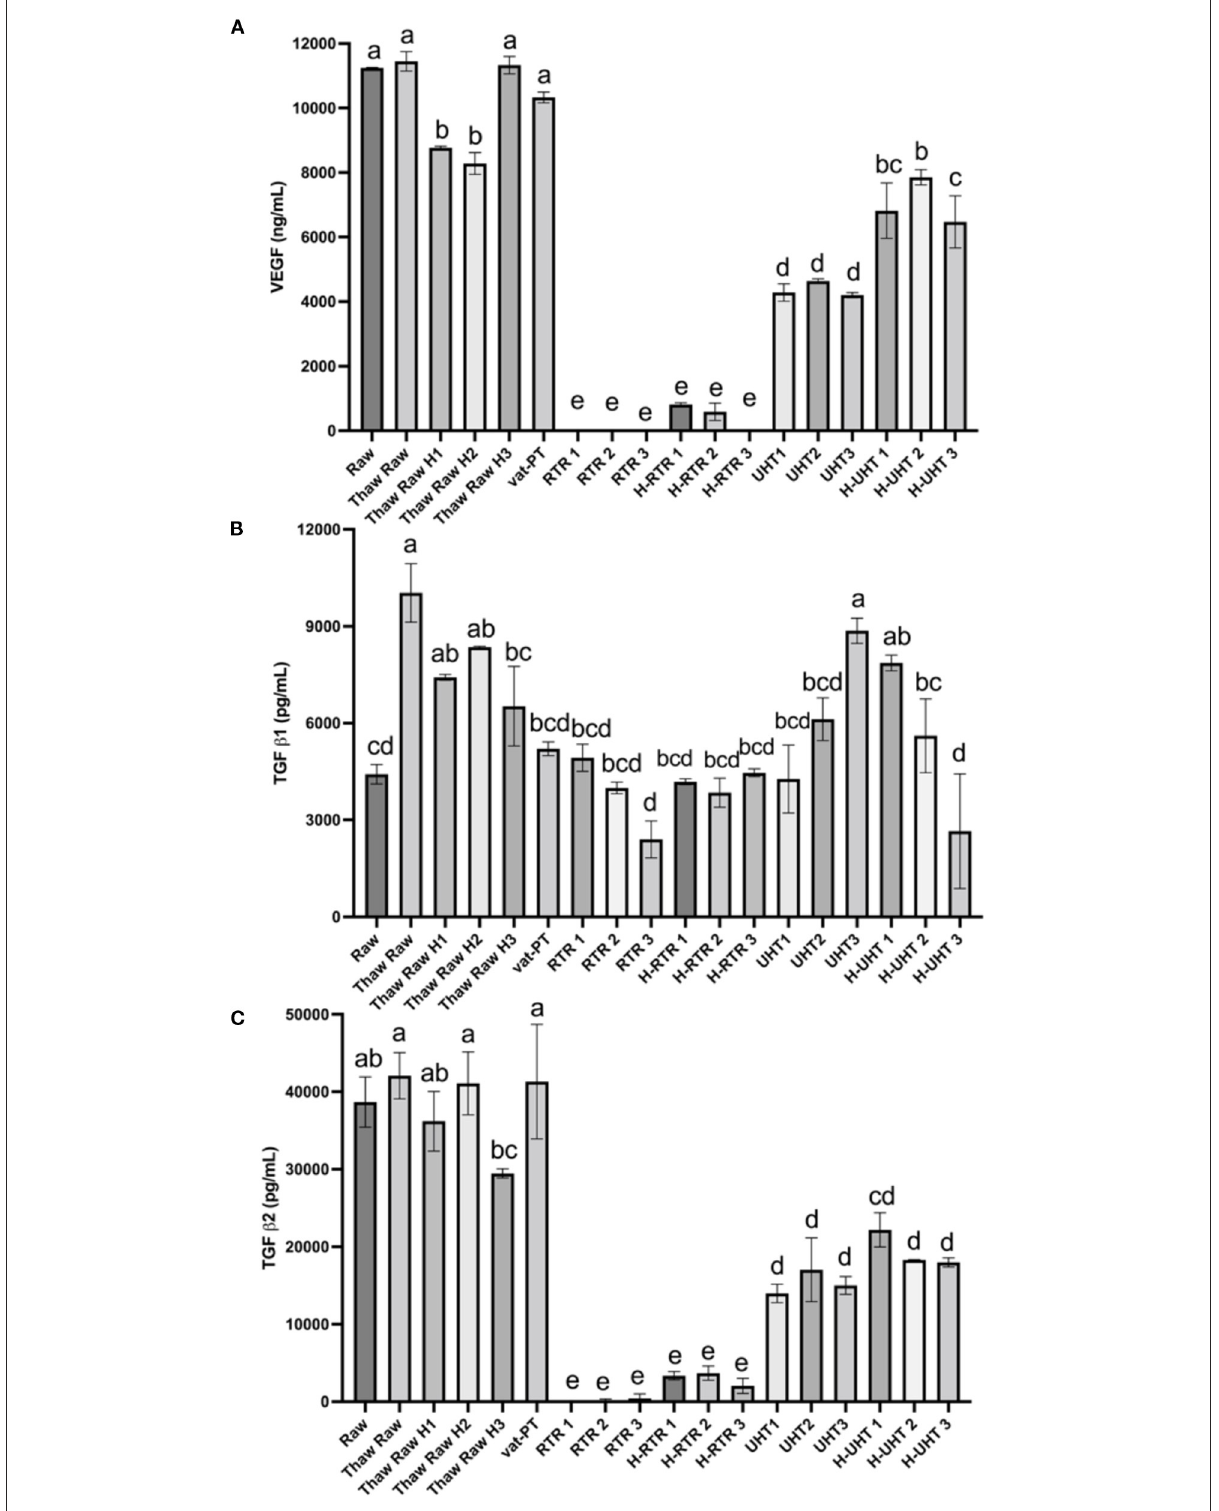
FIGURE5 (A) VEGF, (B) TGF- β 1, and (C) TGF- β 2 concentrations in the donor human milk samples: raw milk (Raw), thawed raw milk (Thaw Raw), thawed and homogenized raw milk (Thaw Raw H1, 2, and 3), vat-pasteurized milk (Vat-PT), retort sterilization-treated milk (RTR 1, 2, and 3), homogenized and retort treated milk (H-RTR 1, 2, and 3), ultra-high-temperature treated milk (UHT 1, 2, and 3), and homogenized and ultra-high-temperature treated milk (H-UHT 1, 2, and 3). One-way analysis of variance (ANOVA) with post hoc Tukey’s tests were used to identify significant ( p < 0.05) differences between treatments, denoted by